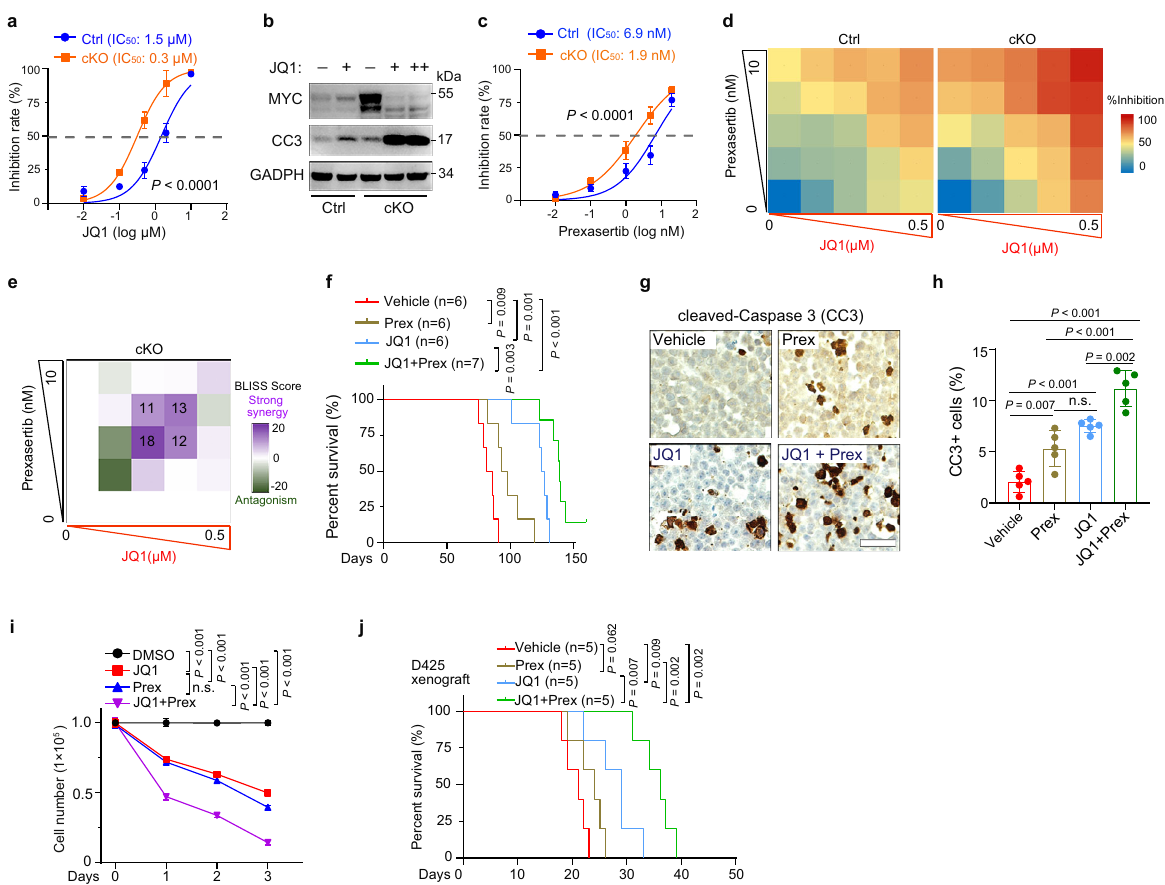
Fig. 7 | Combined targeting MYC and CHEK1 activities inhibits CTDNEP1 - de fi - cienttumorprogression.a Cellviabilityofcontroland Ctdnep1 -cKONPCstreated with the indicated concentrations of JQ1 relative to vehicle-treated cells. Data represent means±SD, n=5 independent experiments. b Representative immuno- blotsfrom3independentexperimentsforMYCandcleavedCaspase3incontrolor Ctdnep1 -cKONPCstreatedwithJQ1(0.5 μ M:+;1 μ M:++)orDMSO( − ). c Cellviability of Ctdnep1- cKONPCsandwild-typeNPCstreatedwithprexasertib(Prex)for3days at indicated concentrations relative to vehicle-treated cells. d , e Heatmap showing the percentage of growth inhibitionof Ctdnep1- cKO tumorsand wild-typeNPCsby combined treatment with JQ1 and prexasertib relative to vehicle-treated cells ( d ); Bliss score for JQ1 and prexasertib double titrations ( e ). n =5 independent experi- ments. f Kaplan-Meier survival for Ctdnep1- cKO tumor-bearing allografts treated withvehicle,JQ1,prexasertib,orJQ1andprexasertibcombinedtreatmentonce/day